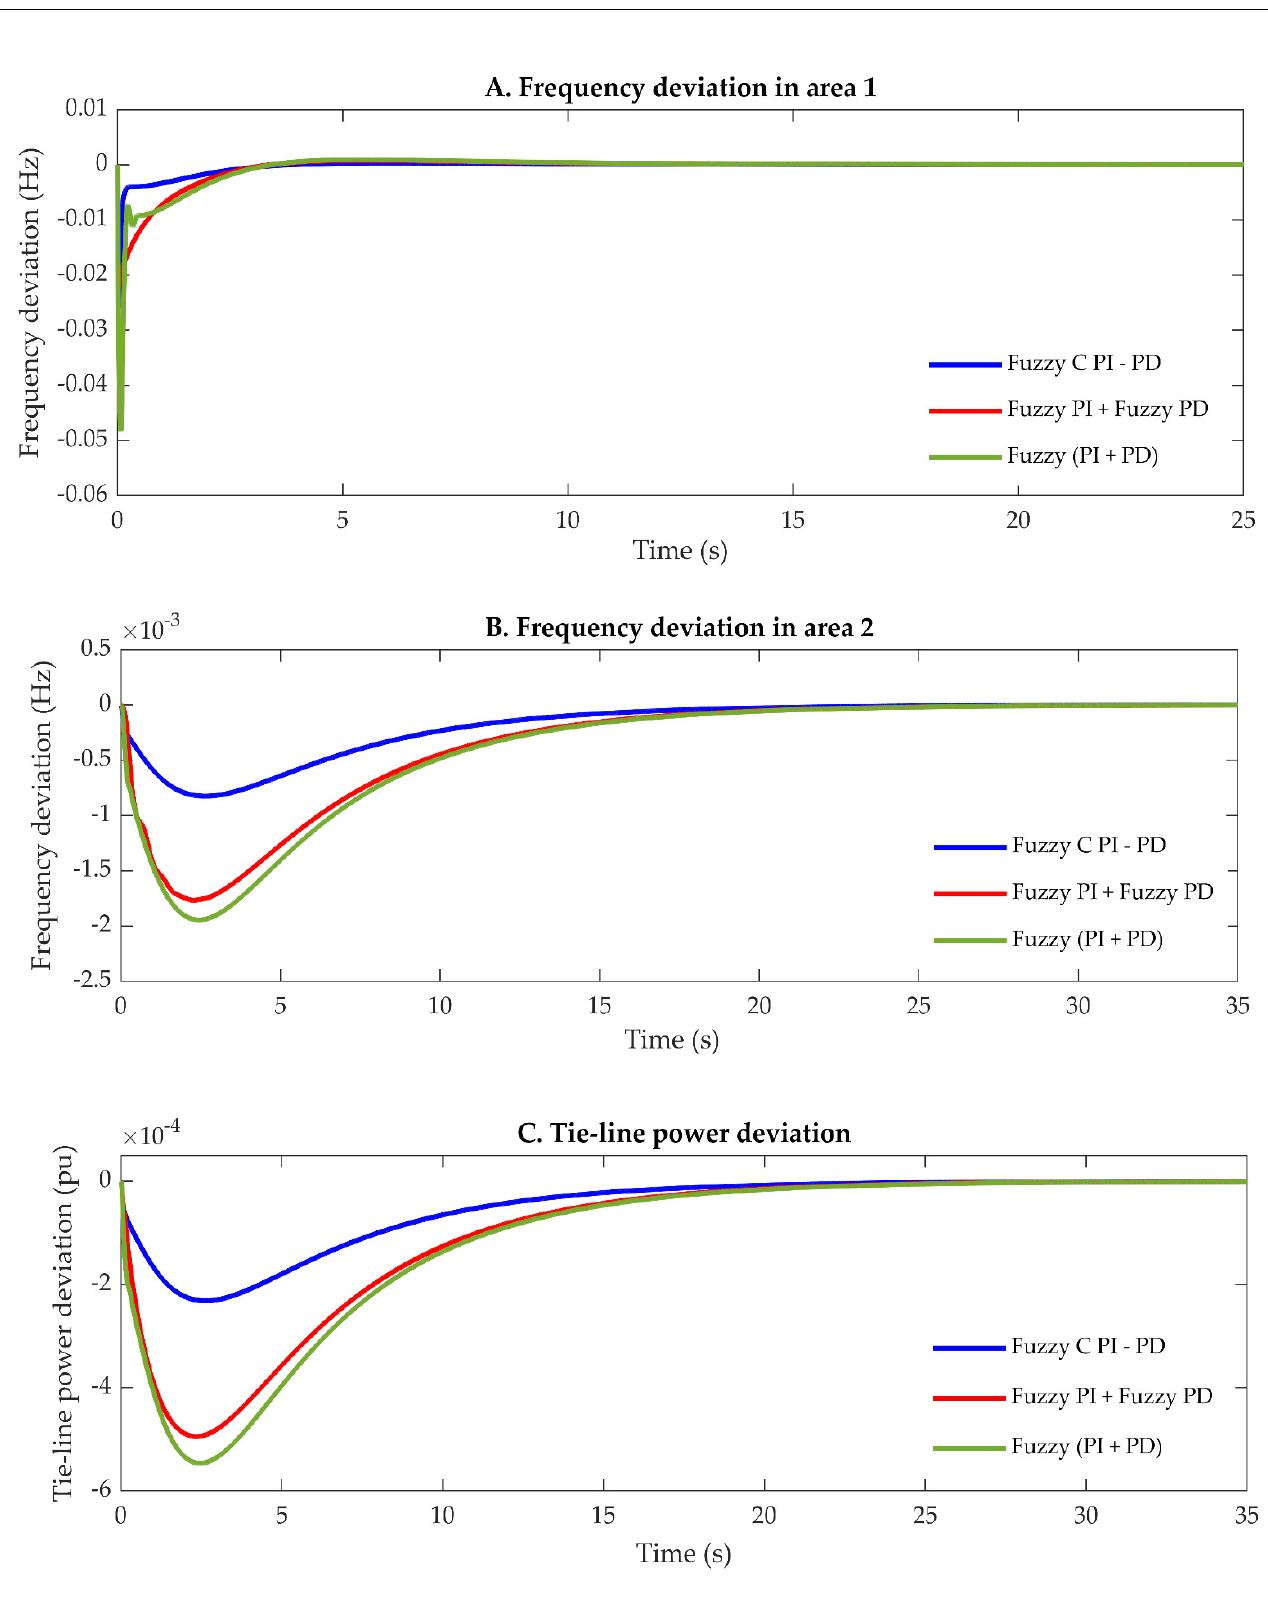
Figure 25. Dynamic response of the testbed power system based on different fuzzy controllers under parametric uncertainty conditions, case 4. ( A ) Frequency variation in area 1; ( B ) frequency variation in area 2; ( C ) tie-line power variation.